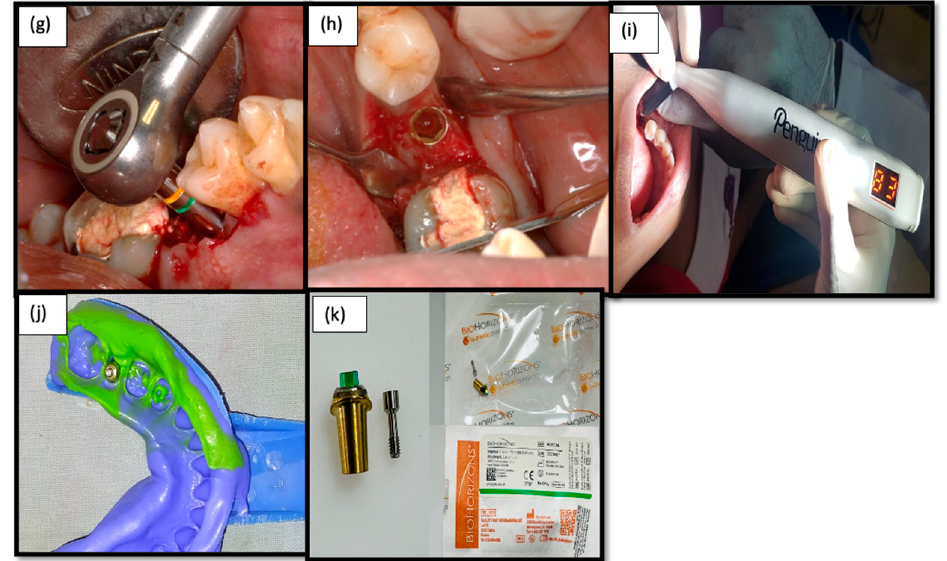
Figure 3. ( g ) Implant driven in using a Bio-horizon torque wrench ; ( h ) Laser Micro-grooved implant placed and cover screw given ; ( i ) Resonance frequency analysis for prosthetic loading ; ( j ) Putty impression taken for prosthetic restoration; ( k ) Laser micro-grooved abutment – Laser Lok ®